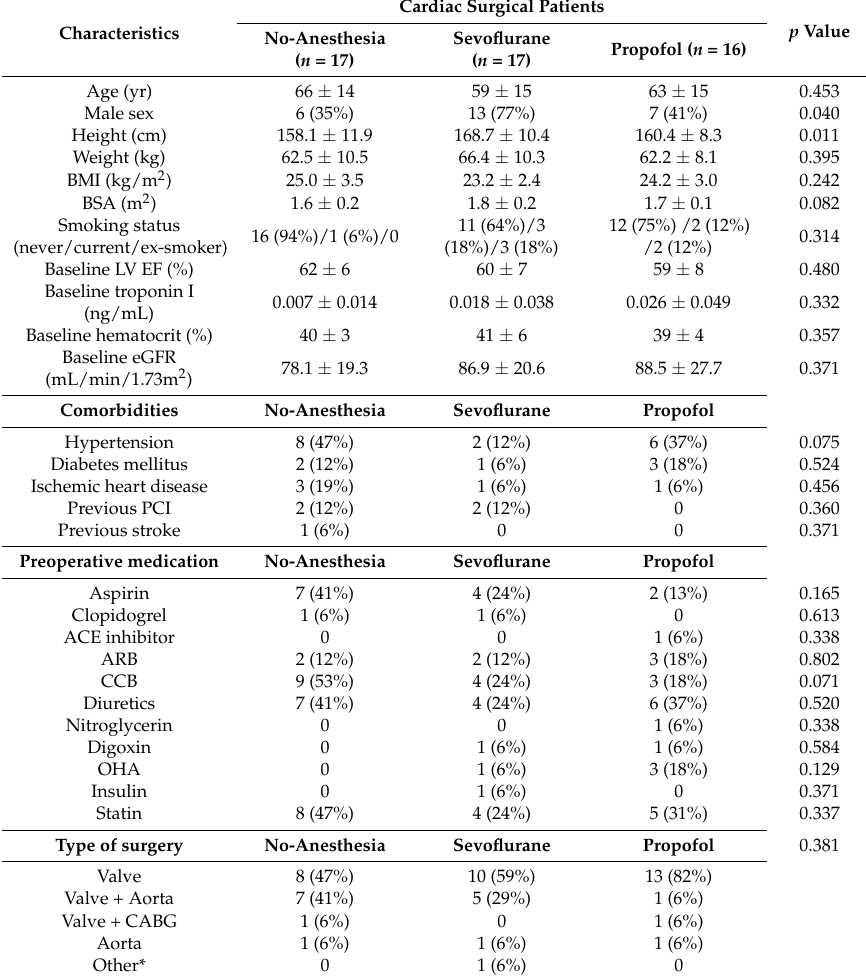
Table 1. Characteristics of cardiac surgery patients.